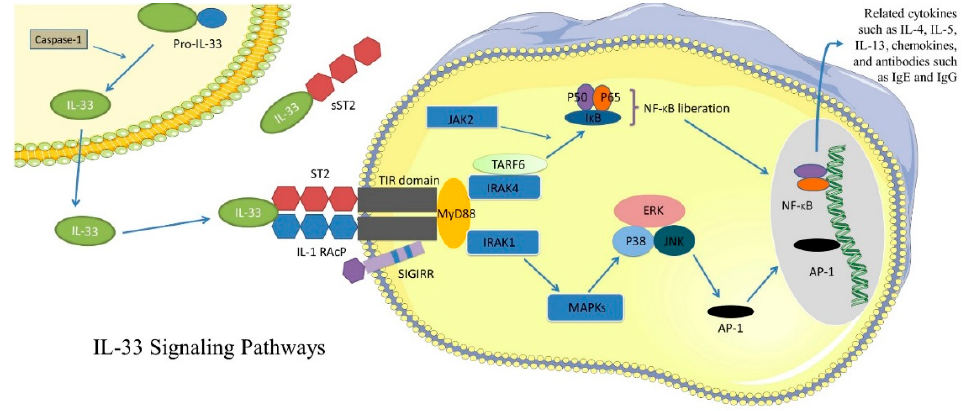
Figure 1. IL-33 signaling pathway. IL-33 binds with ST2 transmembrane isoform and IL-1 receptor accessory protein (IL-1RAcP), leading to the downstream activation of several signaling pathways. MyD88 recruitment at TIR domain is essential for IL-33-ST2-mediated signaling cascade. On one hand, the downstream activation of TRAF6 and IRAK4 proteins activates the inhibitor of nuclear factor- κ B kinase (IKK) complex, leading to NF- κ B activation. On the other hand, in the absence of TRAF6, downstream activation of MAPKs leading to activation of AP-1. Next, NF- κ B and AP-1 bind to DNA and induce the expression of various Th2-related cytokines, chemokines and antibodies. sST2 acts as a decoy receptor and results in the competitive inhibition of IL-33 biological activity. Single Ig IL-1R-related molecule (SIGIRR) acts as negative regulator for TIR signaling, leading to the suppression of IL-33/ST2 signaling pathways.